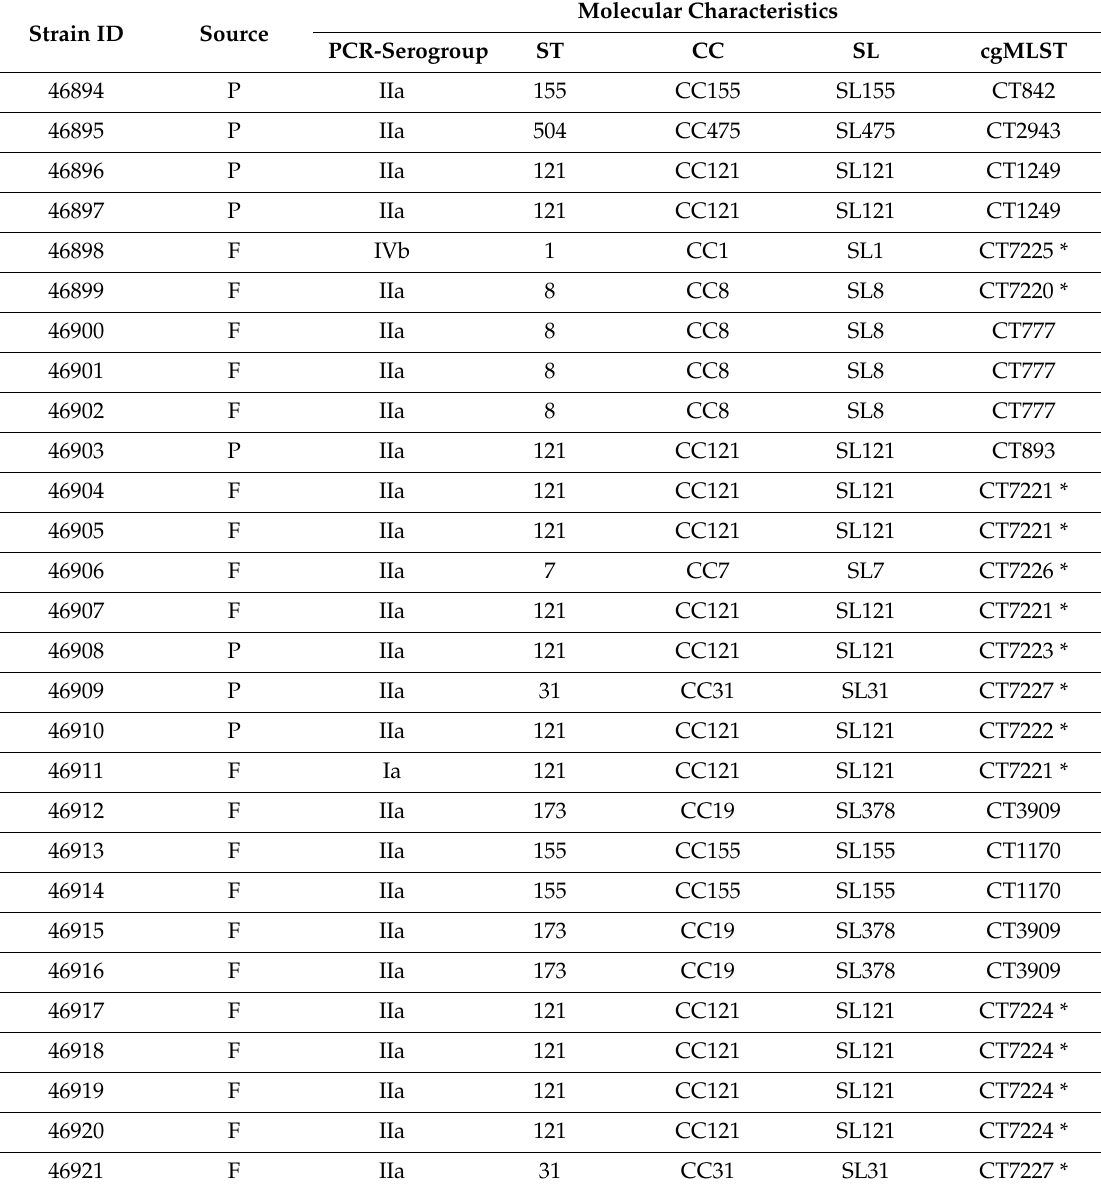
Table 1. Molecular characteristic of L. monocytogenes strains